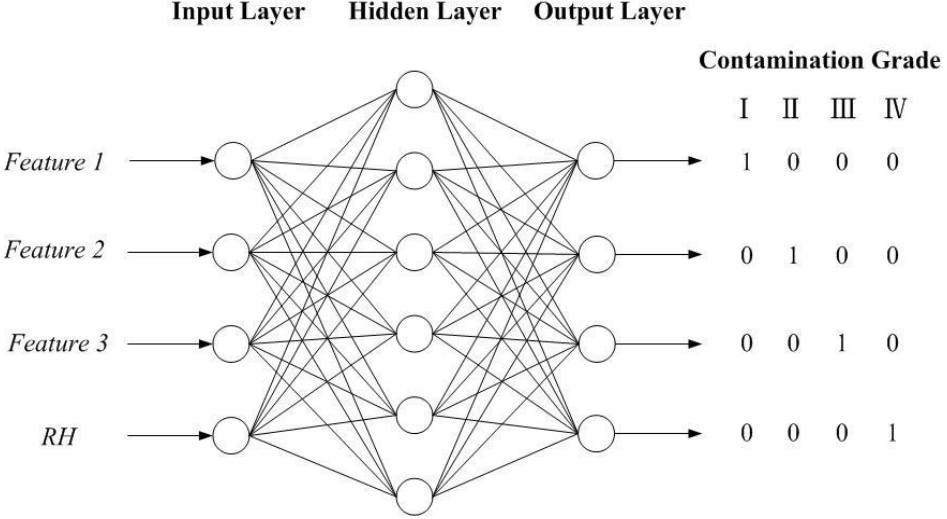
Figure 16. Structure of